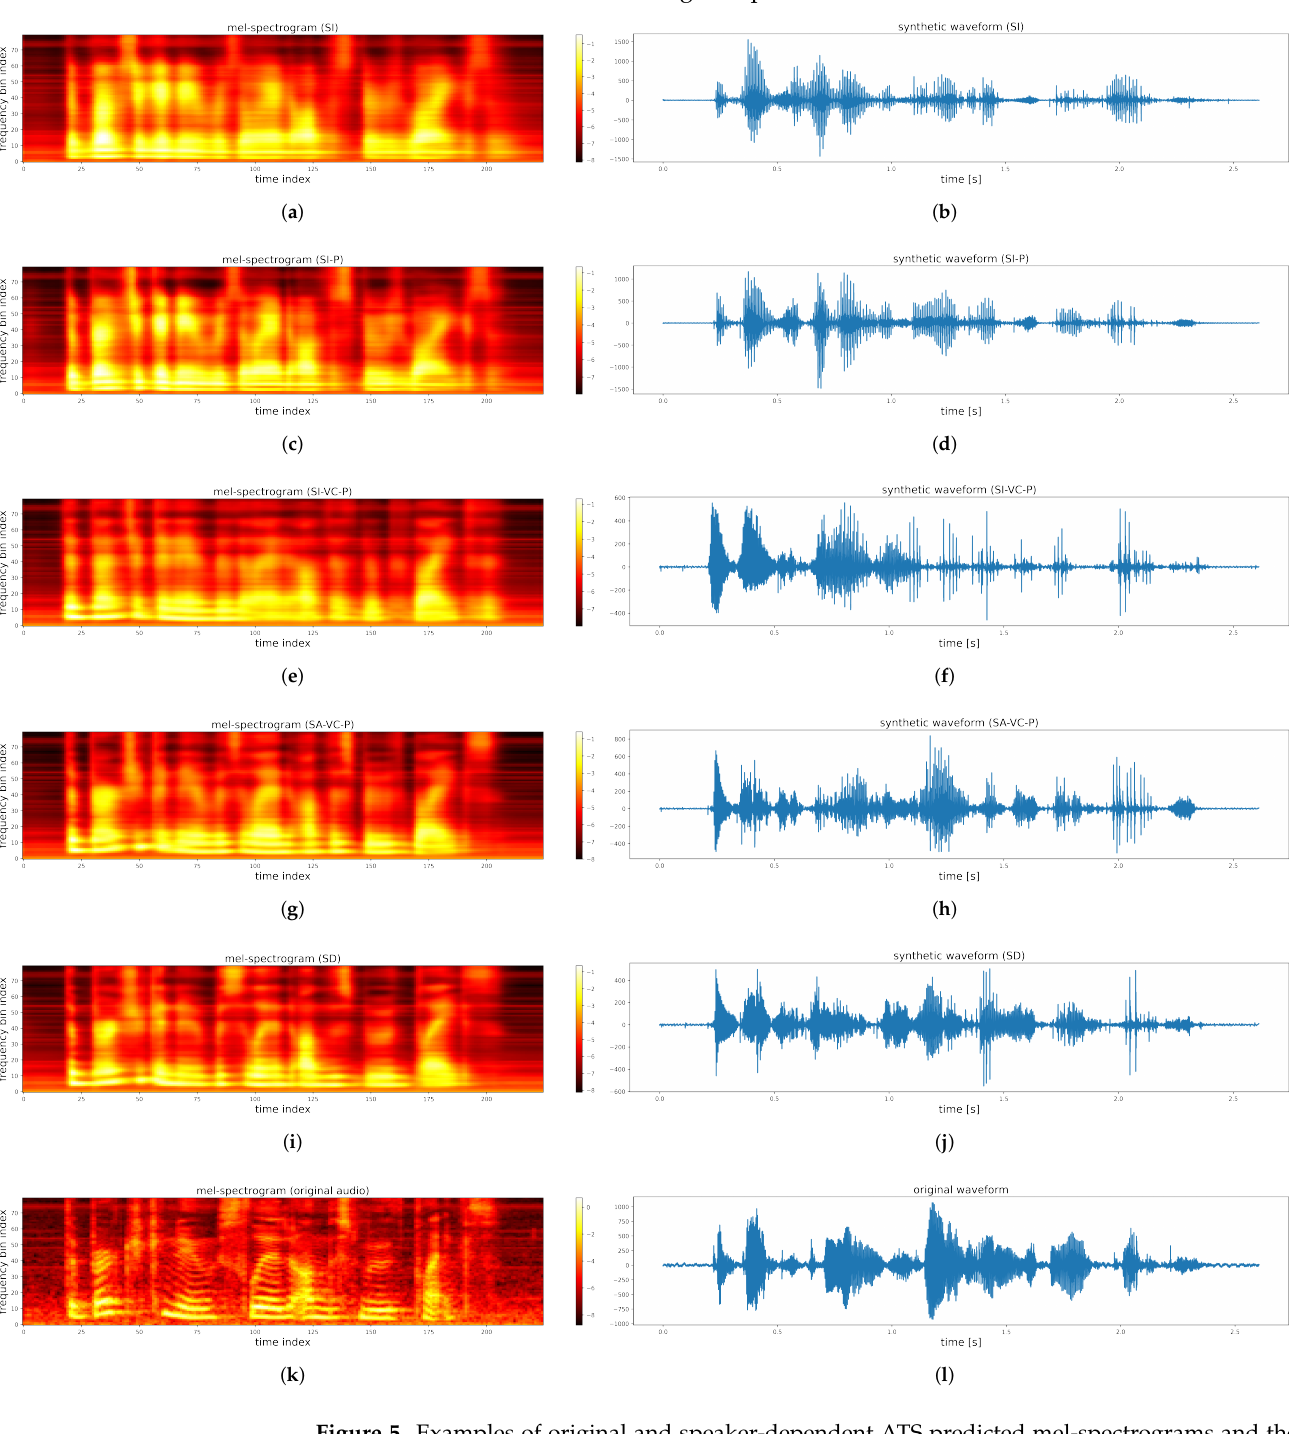
Figure 5. Examples of original and speaker-dependent ATS predicted mel-spectrograms and the synthetic waveforms. ( a ) Mel-spectrogram from SI ATS. ( b ) Speech waveform from SI ATS. ( c ) Mel- spectrogram from SI-P ATS. ( d ) Speech waveform from SI-P ATS. ( e ) Mel-spectrogram from SI-VC-P ATS. ( f ) Speech waveform from SI-VC-P ATS. ( g ) Mel-spectrogram from SA-VC-P ATS. ( h ) Speech waveform from SA-VC-P ATS. ( i ) Mel-spectrogram from SD ATS. ( j ) Speech waveform from SD ATS. ( k ) Original mel-spectrogram. ( l ) Original speech